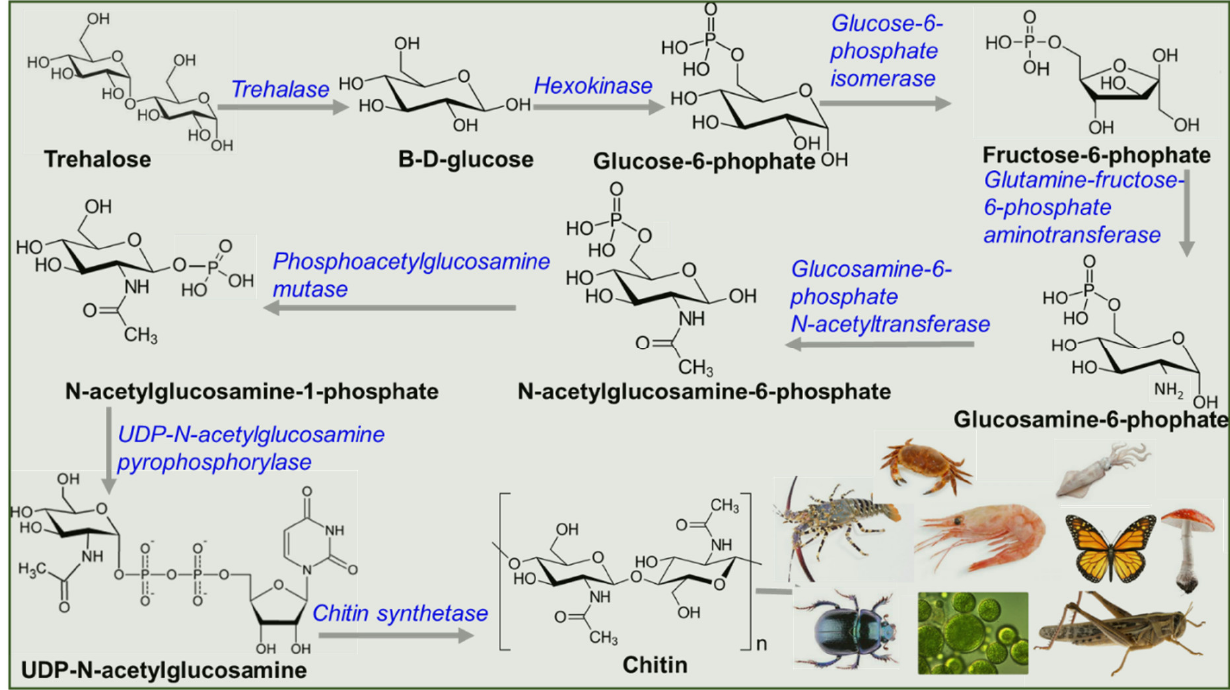
Figure 2. Chitin biosynthesis pathway.